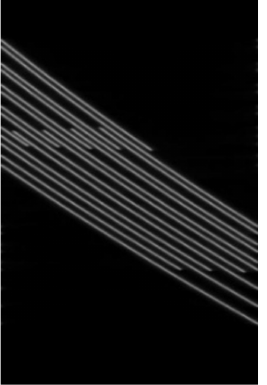
Figure 2. Data after range